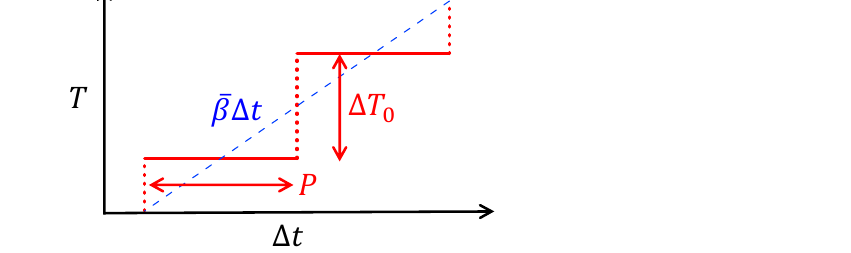
Figure 3. Temperature protocol of periodic temperature jumps with subsequent isothermal holding steps utilized in T-M FSC: 𝛽̅ = ∆𝑇 0 /𝑃 .